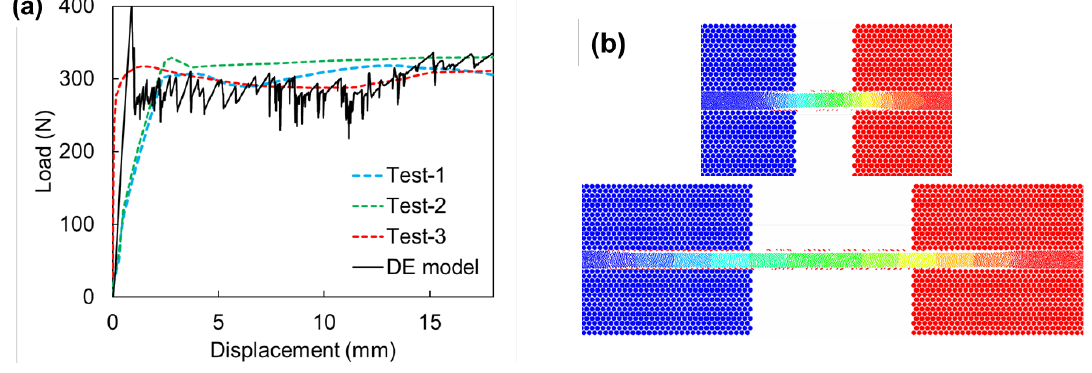
Fig. 4: Numerical result and observation. a) Comparison of experimental and numerical results. b) Stretch of PVB interlayer.